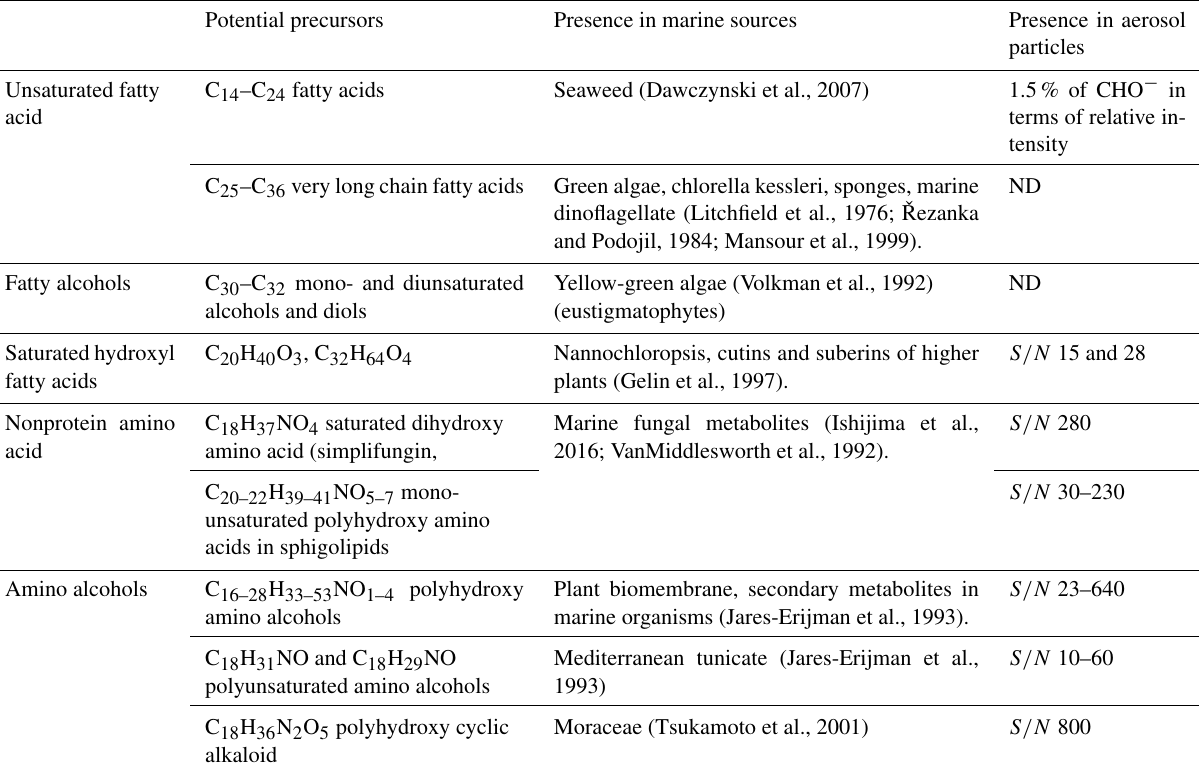
Table 3. Possible precursors and their presence in marine biological sources and our aerosol samples. ND: not detected. Potential precursors Presence in marine sources Presence in aerosol particles Seaweed (Dawczynski et al., 2007) 1.5% of CHO − in terms of relative in- tensity Green algae, chlorella kessleri, sponges,